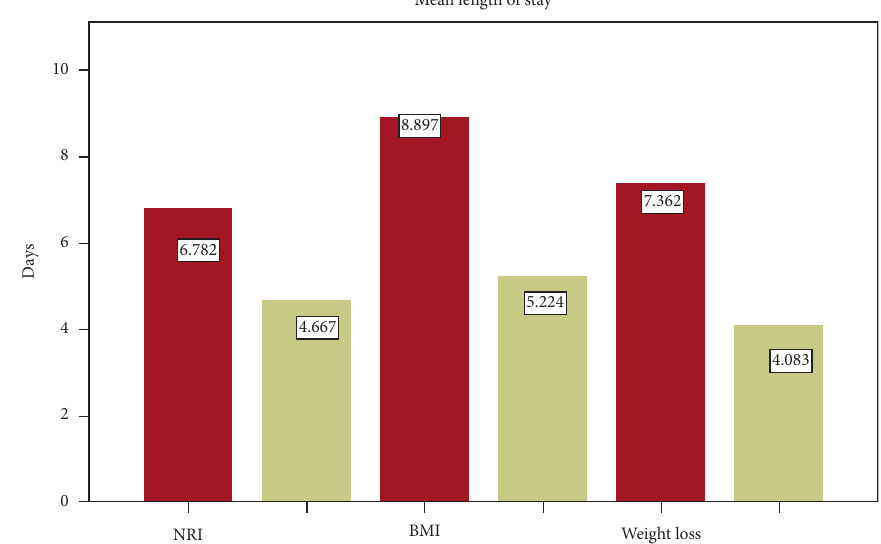
Figure 2: Comparison of length of stay in patients undergoing abdominal surgery with normal nutritional status (gray bar) and un- derweight (red bar); patients with postoperative weight loss (red bar); and no change or gain weight (gray bar) among those undergoing abdominal surgery in hospitals at Wolaita zone in southern Ethiopia, October 2016. NRI: nutritional risk index; BMI: body mass index; weight loss: postoperative weight